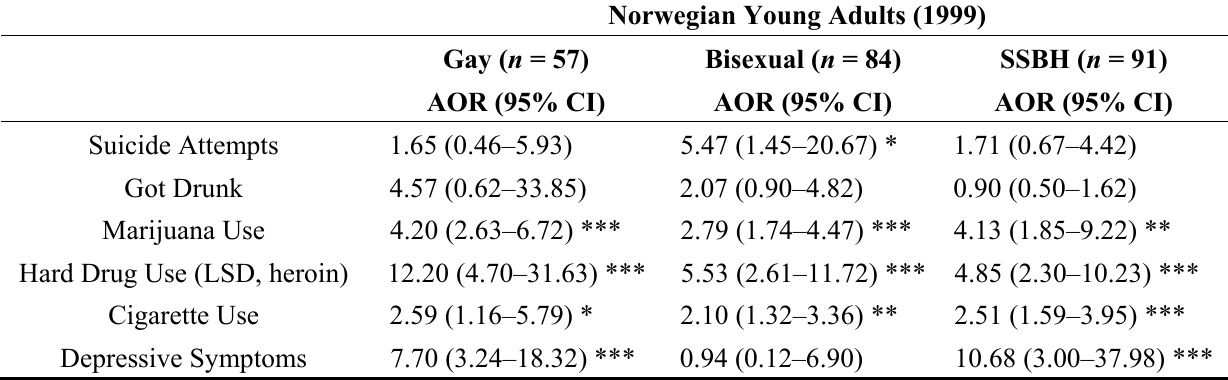
Table 4. Odds of mental health and substance use among sexual minorities compared to heterosexuals (1999) in